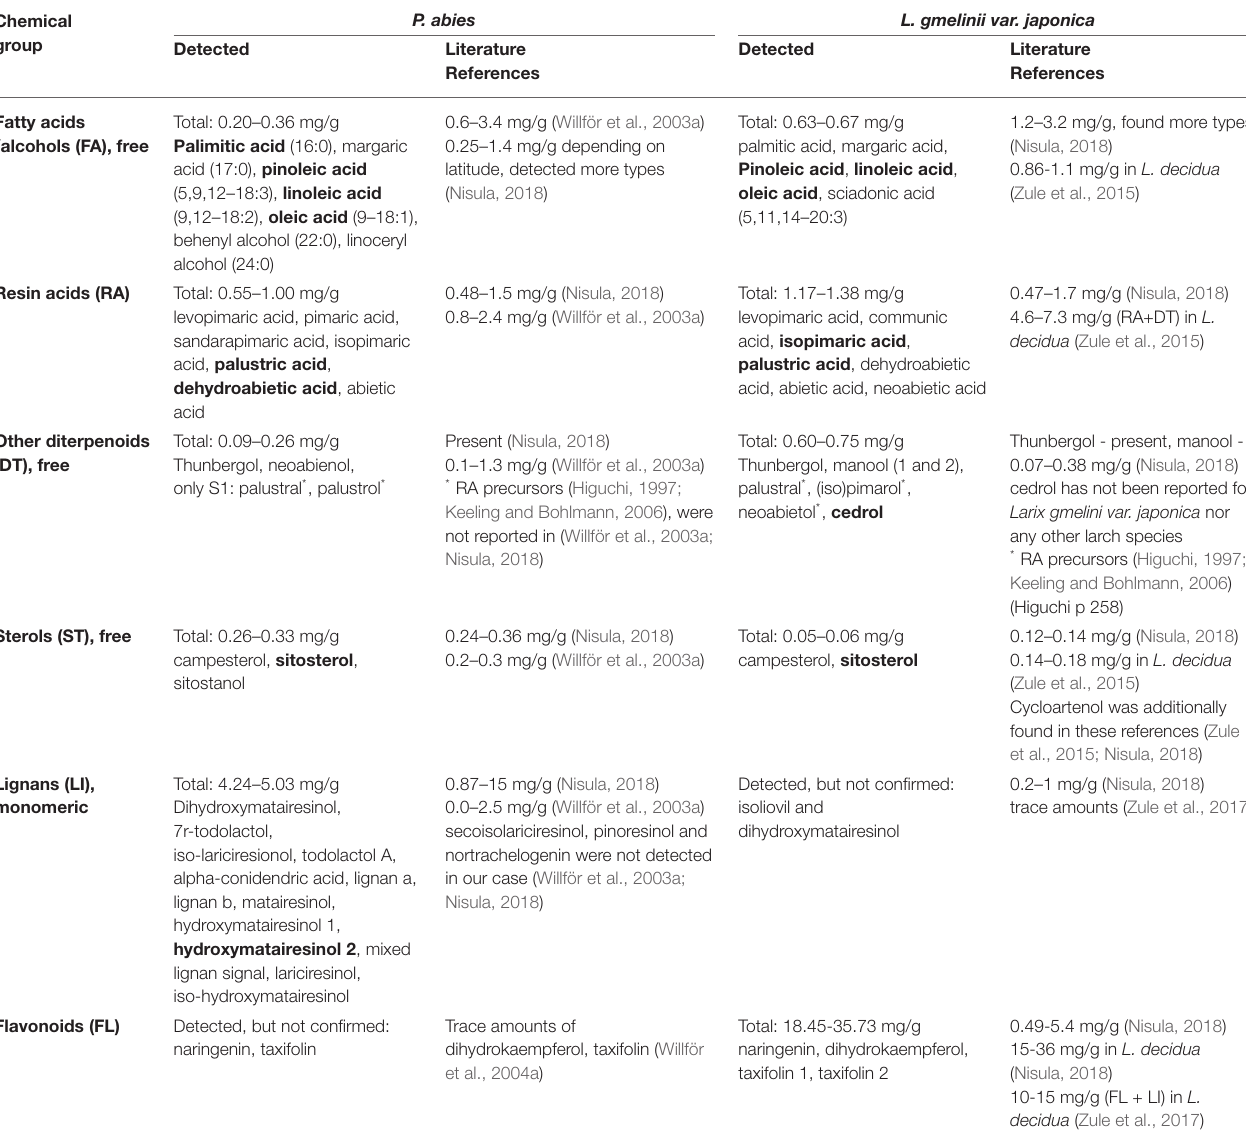
TABLE 2 | Analytes detected in each solvent fraction of Norway spruce and Kurile larch, grouped by chemical class and the class sum ( n = 2), as compared to the literature. Chemical